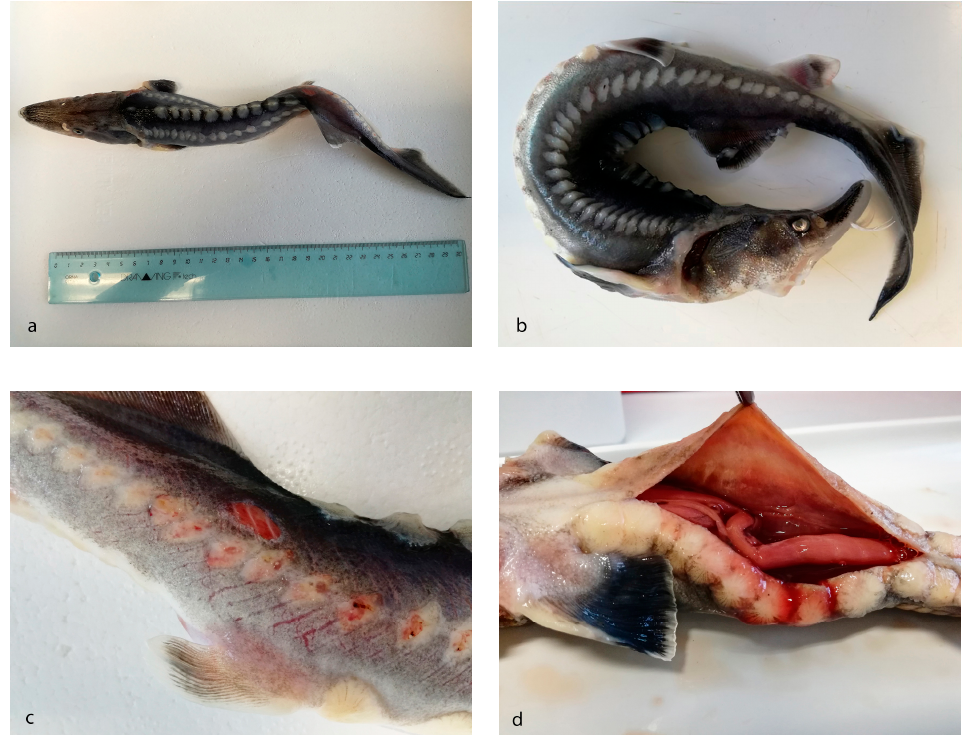
Figure 2. Gross examination Huso huso . ( a , b ) Two diseased animals showing body deformities and U-shaped body curvature. ( c ) Diseased animal showing ulcerative cutaneous erosions and reddening on the back. ( d ) Diseased animal showing a moderate amount of serohemorrhagic effusion in the coelomic cavity.